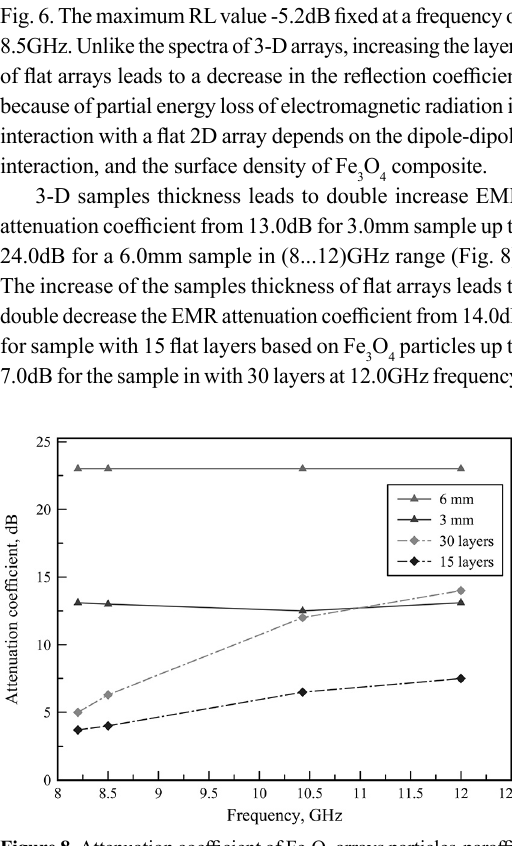
Figure 8. Attenuation coefficient of Fe wax sample and layer of flat arrays versus